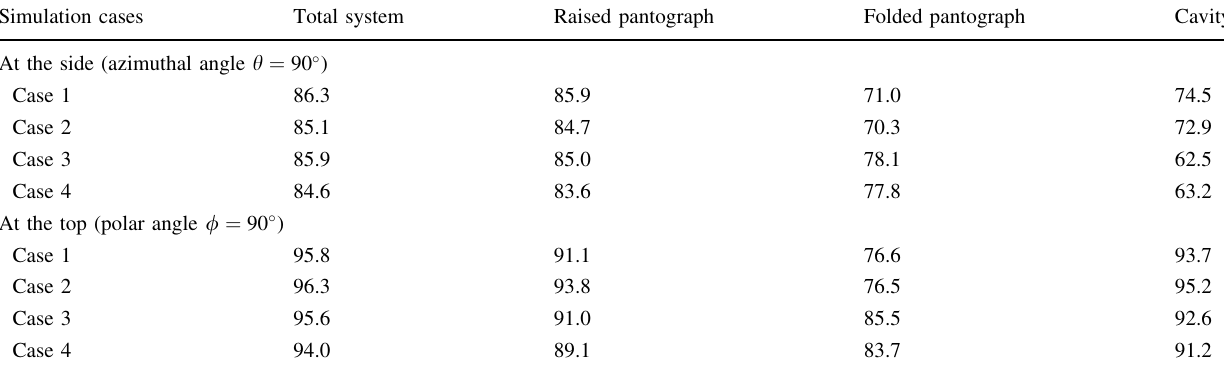
Table 6 OASPLs in dB at the side and the top Simulation cases